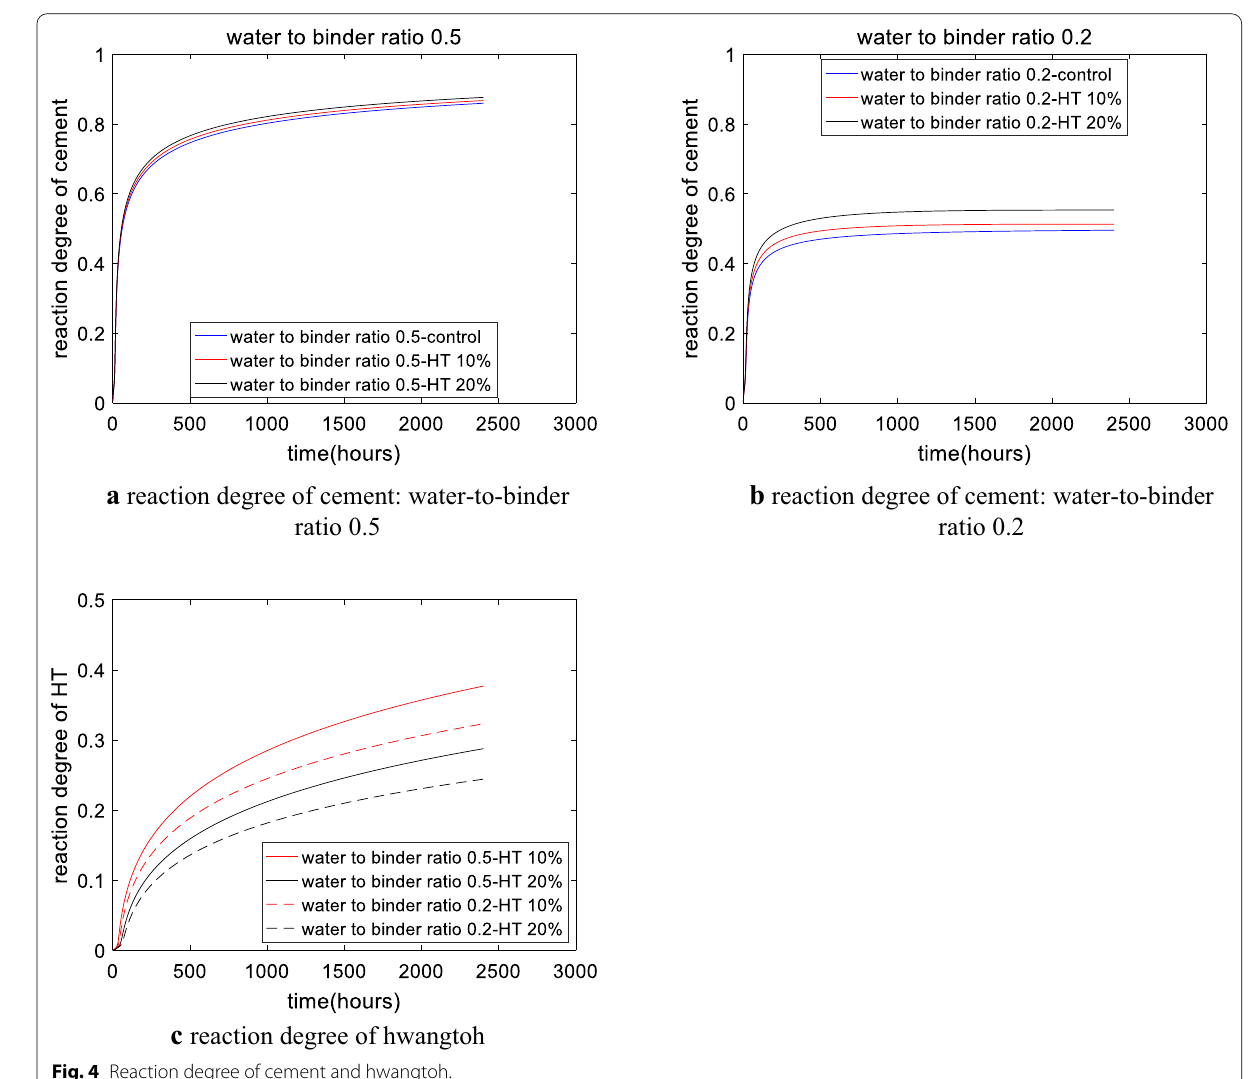
Fig. 4 Reaction degree of cement and